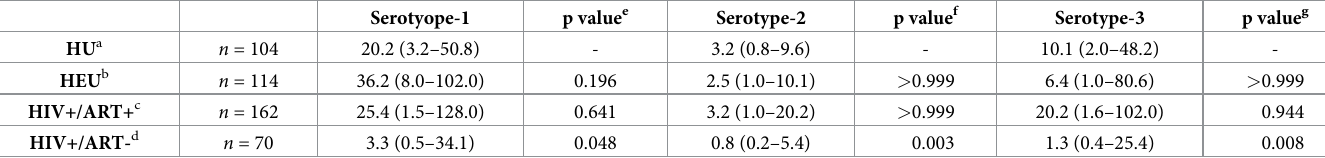
Table 4. Median fold change in antibody titre at 18 weeks of age versus 6 weeks of